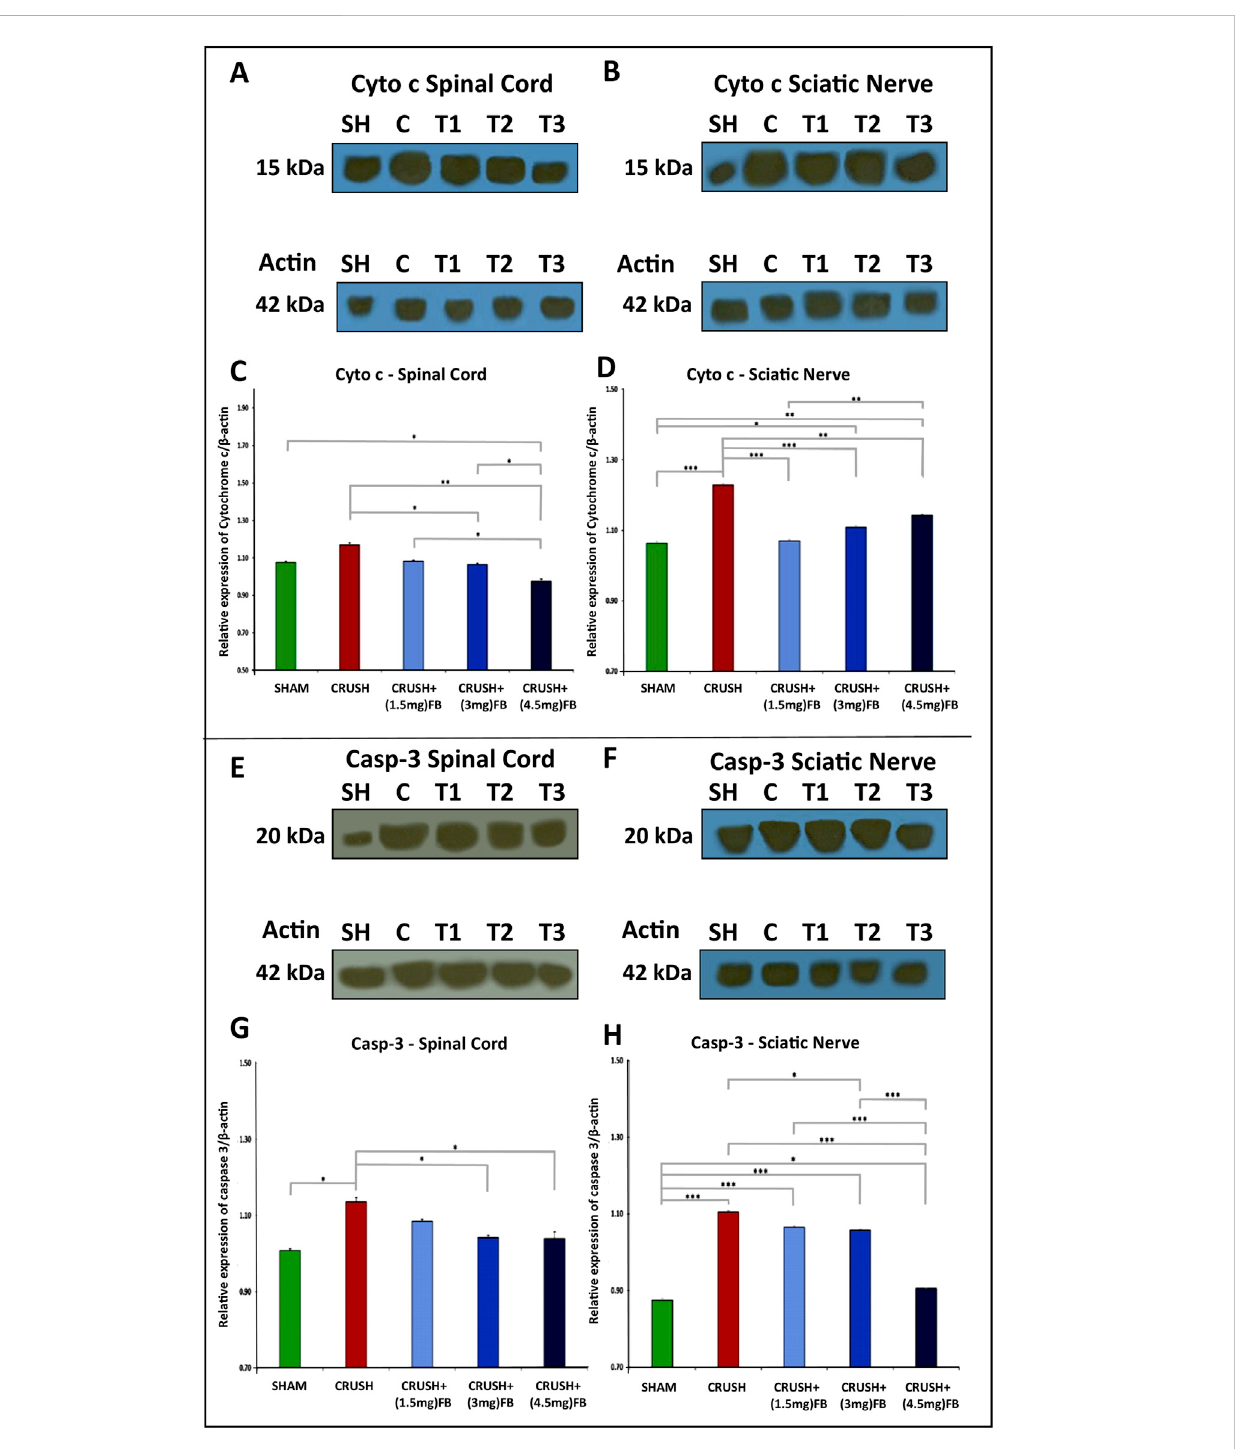
FIGURE 11 (A – D): FB inhibits cytochrome c release after sciatic nerve crush injury. After the injury, spinal cord samples at week 4 after injury were processed for Western blot analysis. Western blot analysis of cytochrome c with cytoplasmic fractions in the spinal cord (A and C) and sciatic nerve (B and D) samples after injury. (C,D) Quantitative Western blotting analysis shows that FB treatment signi fi cantly decreased cytochrome c release into cytoplasm compared with the CRUSH group after injury. Data are expressed as mean ± SEM. * p < 0.05, ** p < 0.01, and *** p < 0.001. (E – H): FB inhibits caspase-3 activation after sciatic nerve crush injury. Western blot analysis of activated caspase-3 in the spinal cord (E and G) and sciatic nerve (F and H) samples after injury. (C,D) Quantitative Western blotting analysis (C,D) shows that the active caspase-3 was increased in the CRUSH group after sciatic nerve crush injury. FB treatment signi fi cantly decreased thelevel of activated caspase-3 compared with the CRUSH group after injury. Data are expressed as mean ± SEM. * p < 0.05, ** p < 0.01, and *** p <